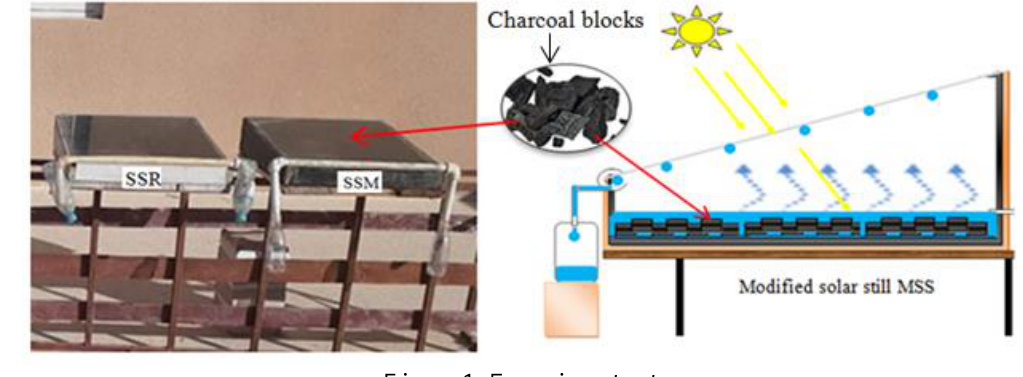
Figure 1. Experiment setup